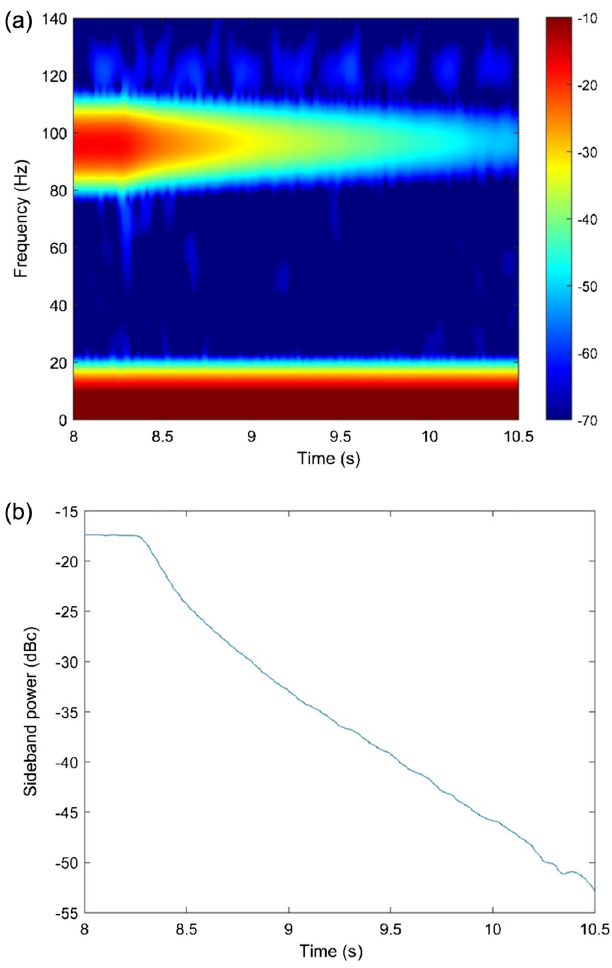
FIG. 10. (a) Spectrogram of the decay time measurement of the dominant 95 Hz mechanical sideband mode. This mode was excited with the mechanical speaker, which was shut off at t ¼ 8 . 25 s. The color map represents the sideband power in the unit of dBc. (b) The decay curve measured at 95 Hz. The decay rate of the mechanical mode energy is − 14 dB =